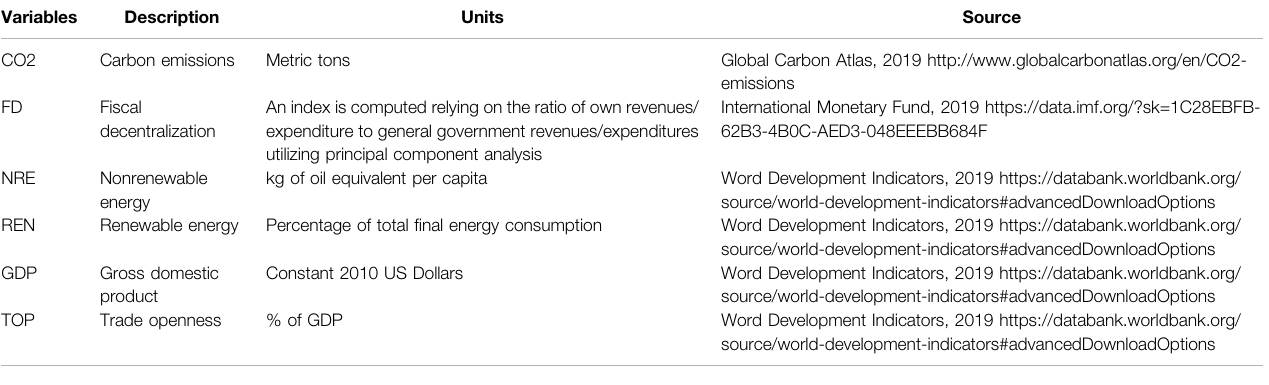
TABLE 1 | Data description.